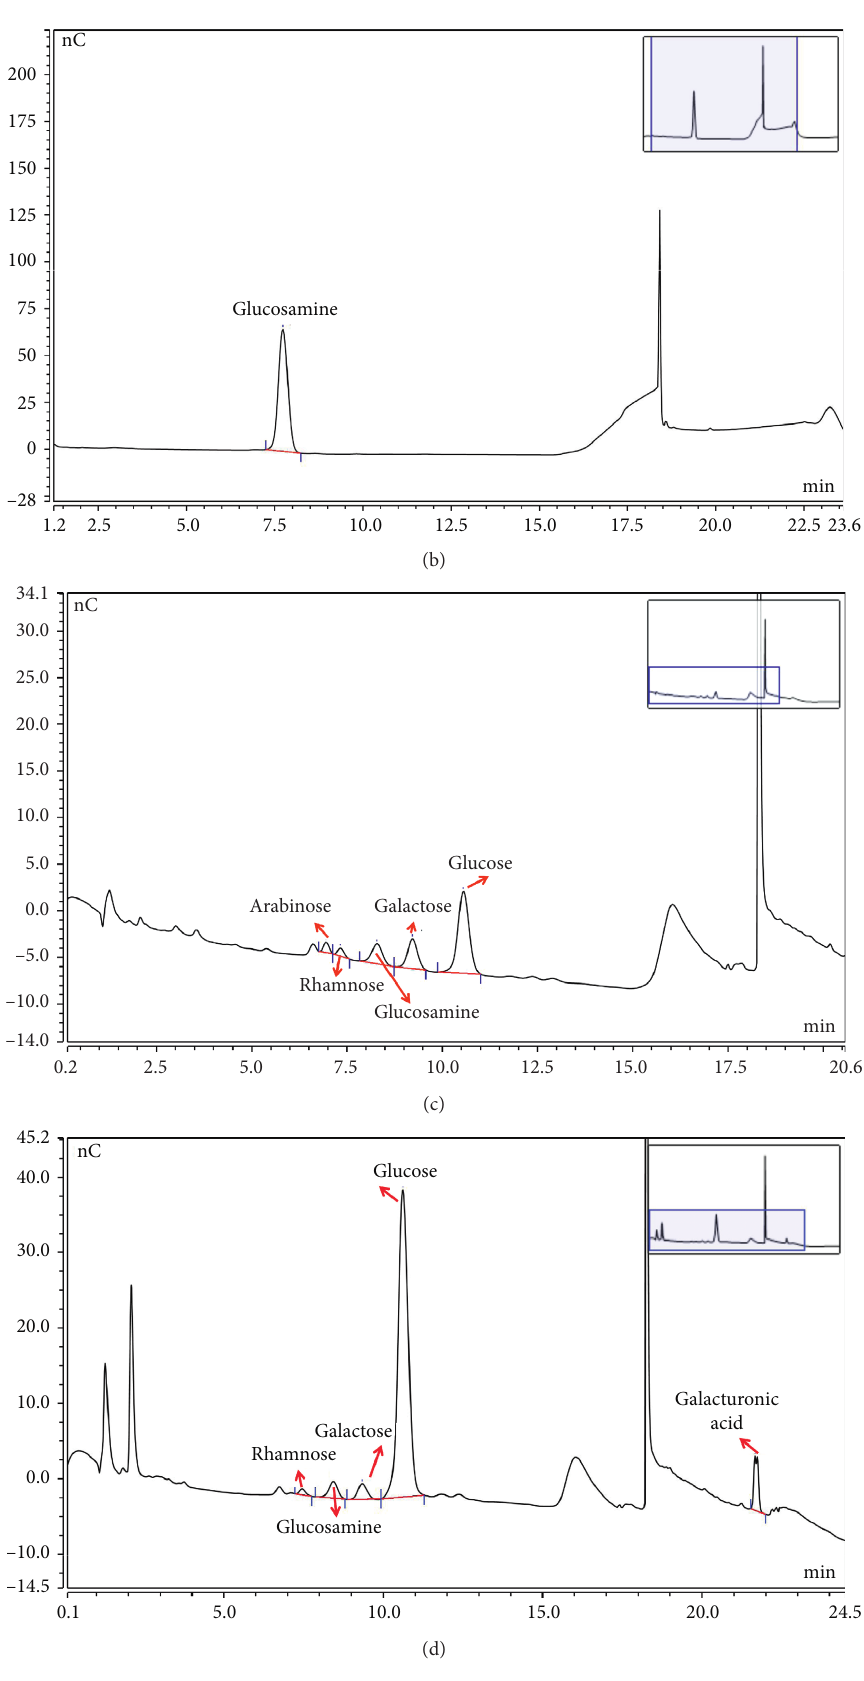
Figure 8: Monosaccharide composition of FTP. (a) 10 standard monosaccharide profiles. (b) Chromatogram of glucosamine standard. (c) The monosaccharide composition of the control group. (d) The monosaccharide composition of the optimized